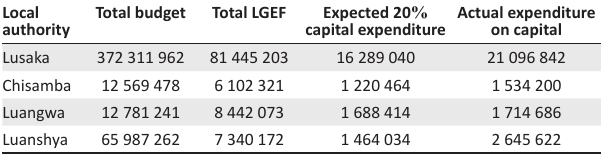
TABLE 2: Capital expenditure for2016 fiscal year in nominal terms (ZMW/million). Local Total budget authority